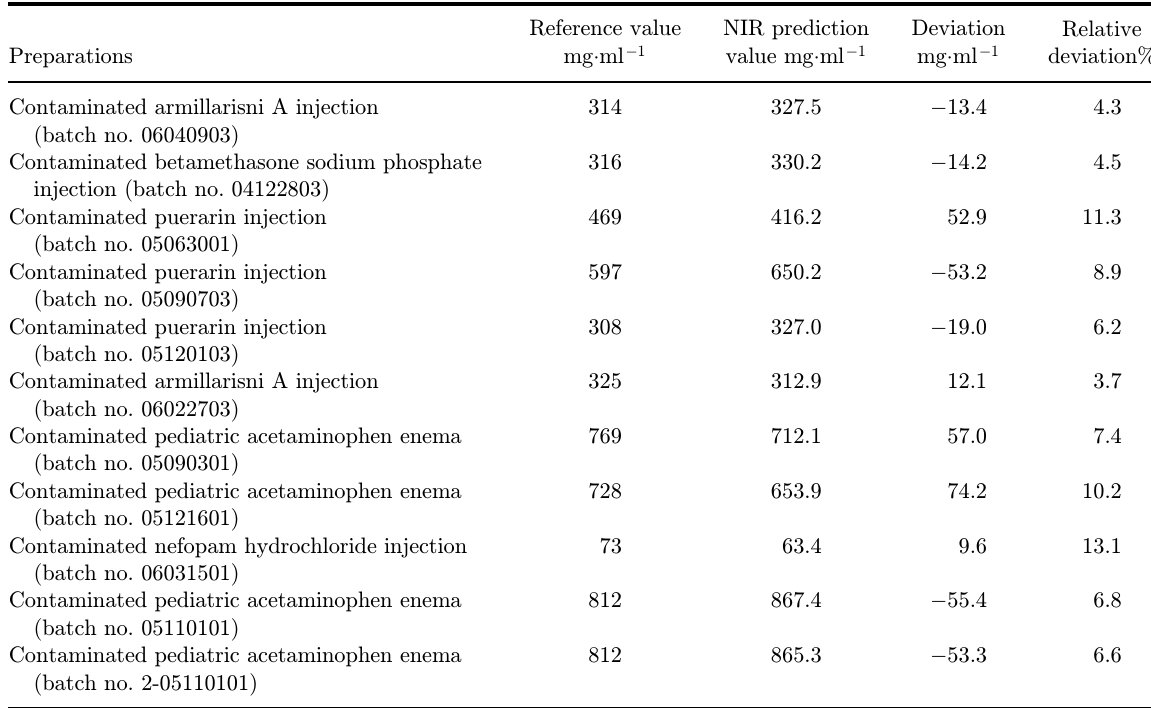
Table 4. Prediction results of real commercial samples by the calibration model for the preparations containing DEG.